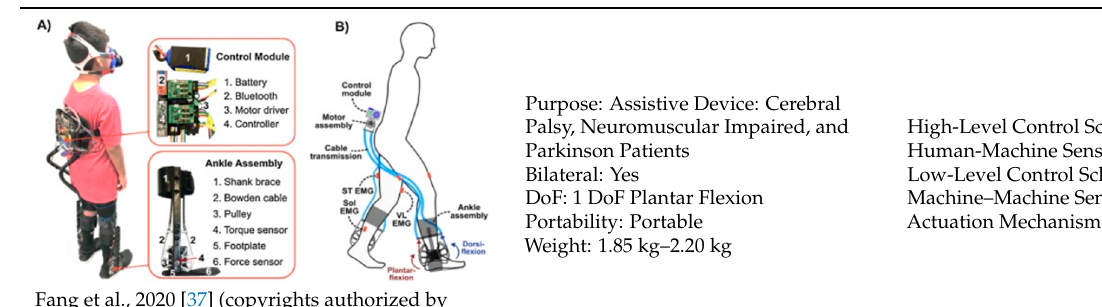
Table 1. An example set of state-of-the-art PAEs selected from the reviewed articles that demonstrate advanced control algorithms, innovative sensor systems, functional actuation units, and practical wearable physical frames.